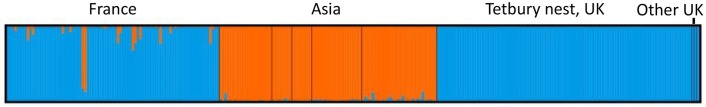
STRUCTURE plot.STRUCTURE plotwith the optimum value of K as two. All the individuals from Tetbury, Somerset and Bath formed a single cluster with samples from France (Blue), and the second cluster was formed the Asian samples (Orange). Each column represents an individual sample blocked by geographic location as indicated. France n = 85 [24]; Asia populations are divided into region from left to right Indonesia n = 21, S Korea n = 8, Vietnam n = 8, Yunnan, China n = 20 and Jiangsu & Zhejiang, China n = 30 [24]; Tetbury nest (n = 101); Other UK includes from left to right Tetbury2 (n = 1), Somerset (n = 1); and Bath (n = 1).